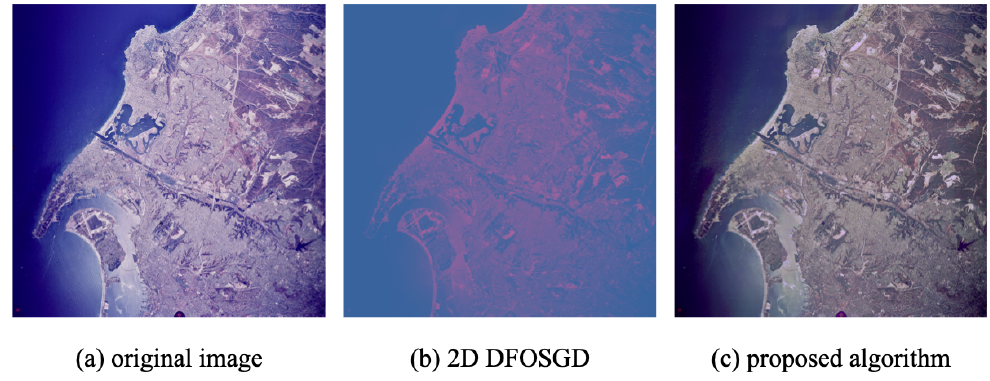
Figure 13. Enhancement results of image “2.2.01”.